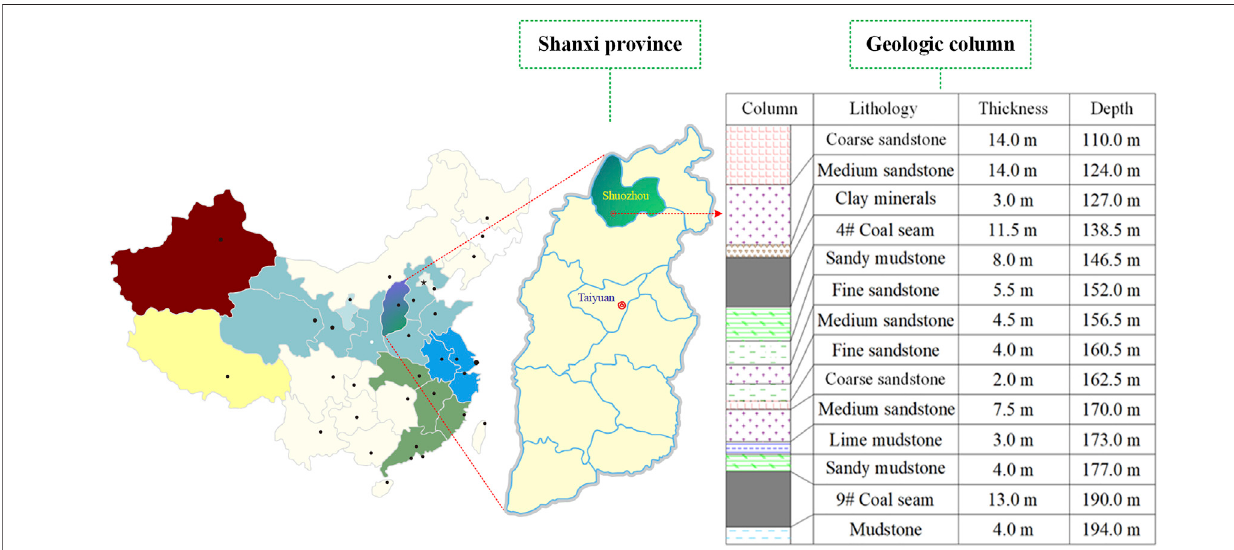
FIGURE 1 | Comprehensive geological histogram of the panel